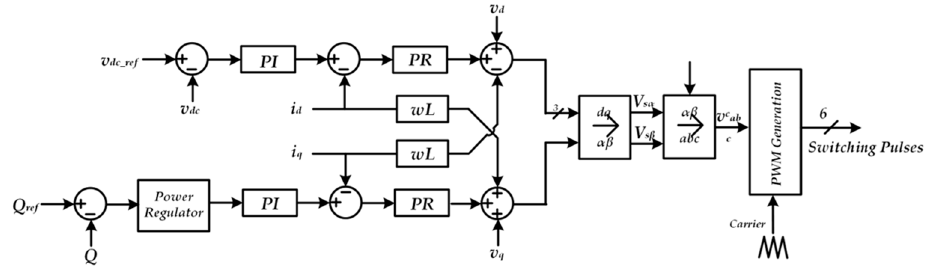
Figure 25. Proportional-Resonant (PR) Control Strategy with dual control loop.